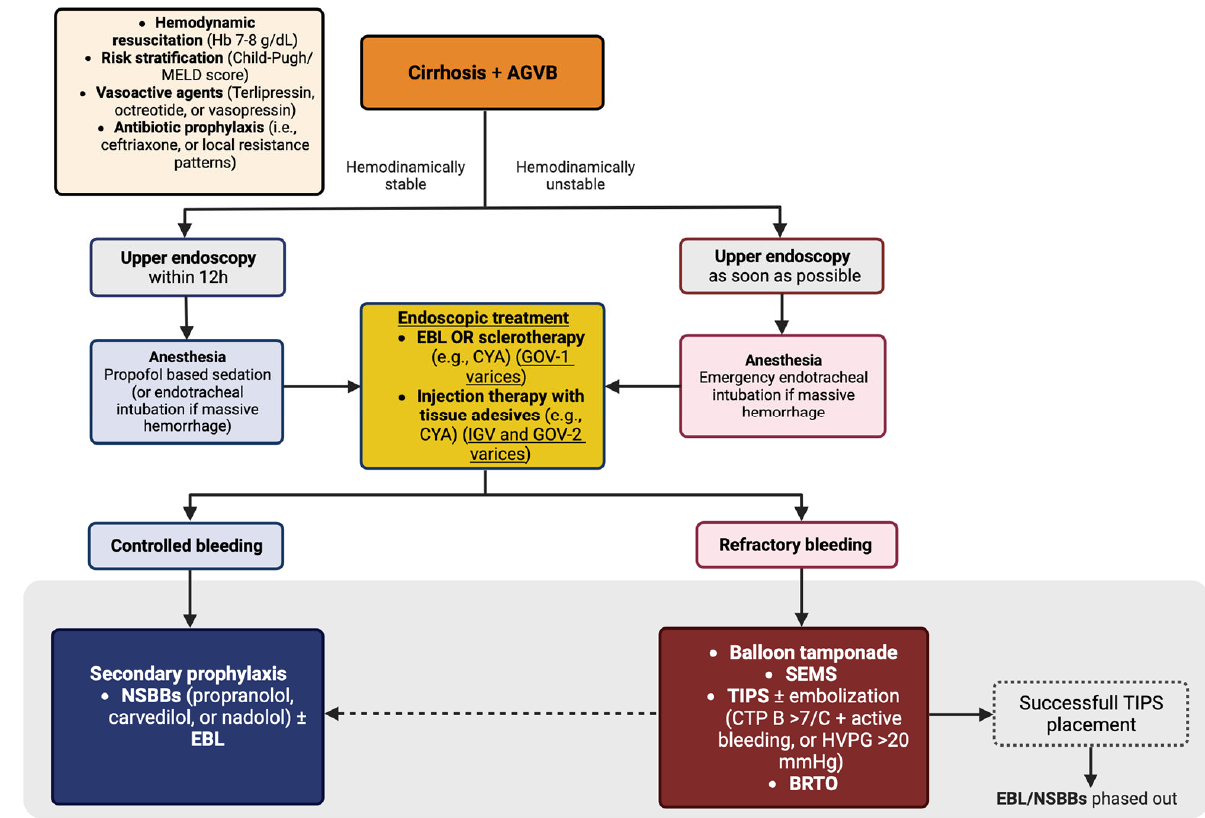
Figure 5. Management of acute gastric variceal bleeding.